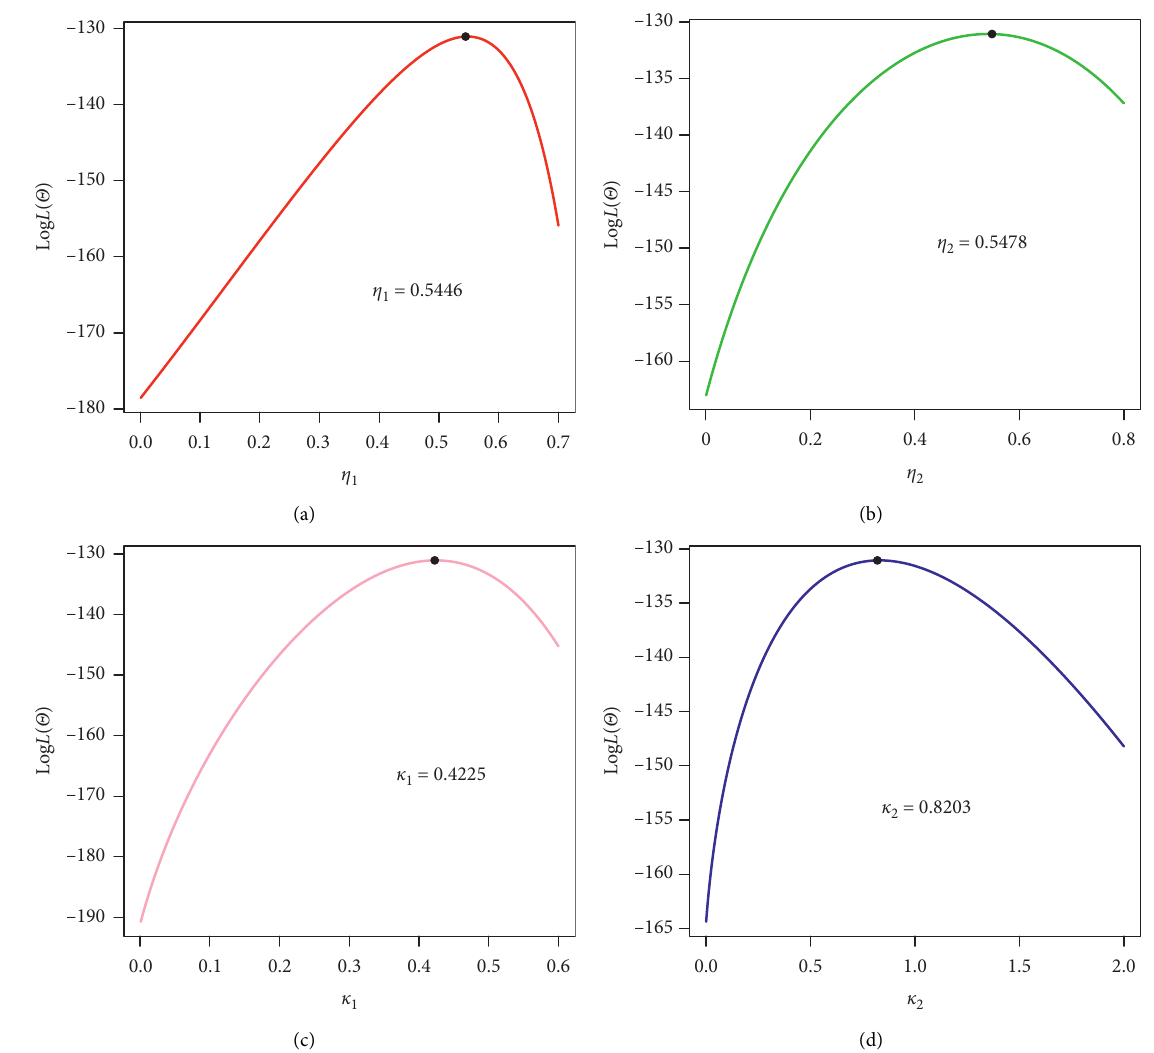
Figure 5: The log-likelihood profile of MLEs of the ASNFEW